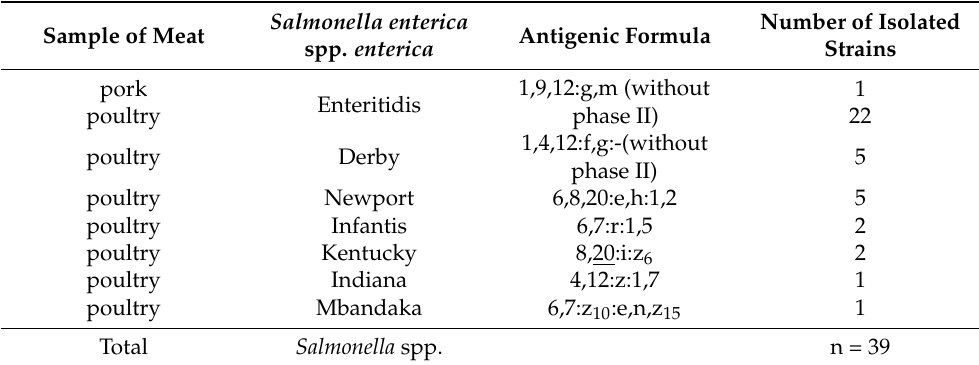
Table 1. The Salmonella enterica subsp. enterica variously identified serovars isolated from meat samples of pork and